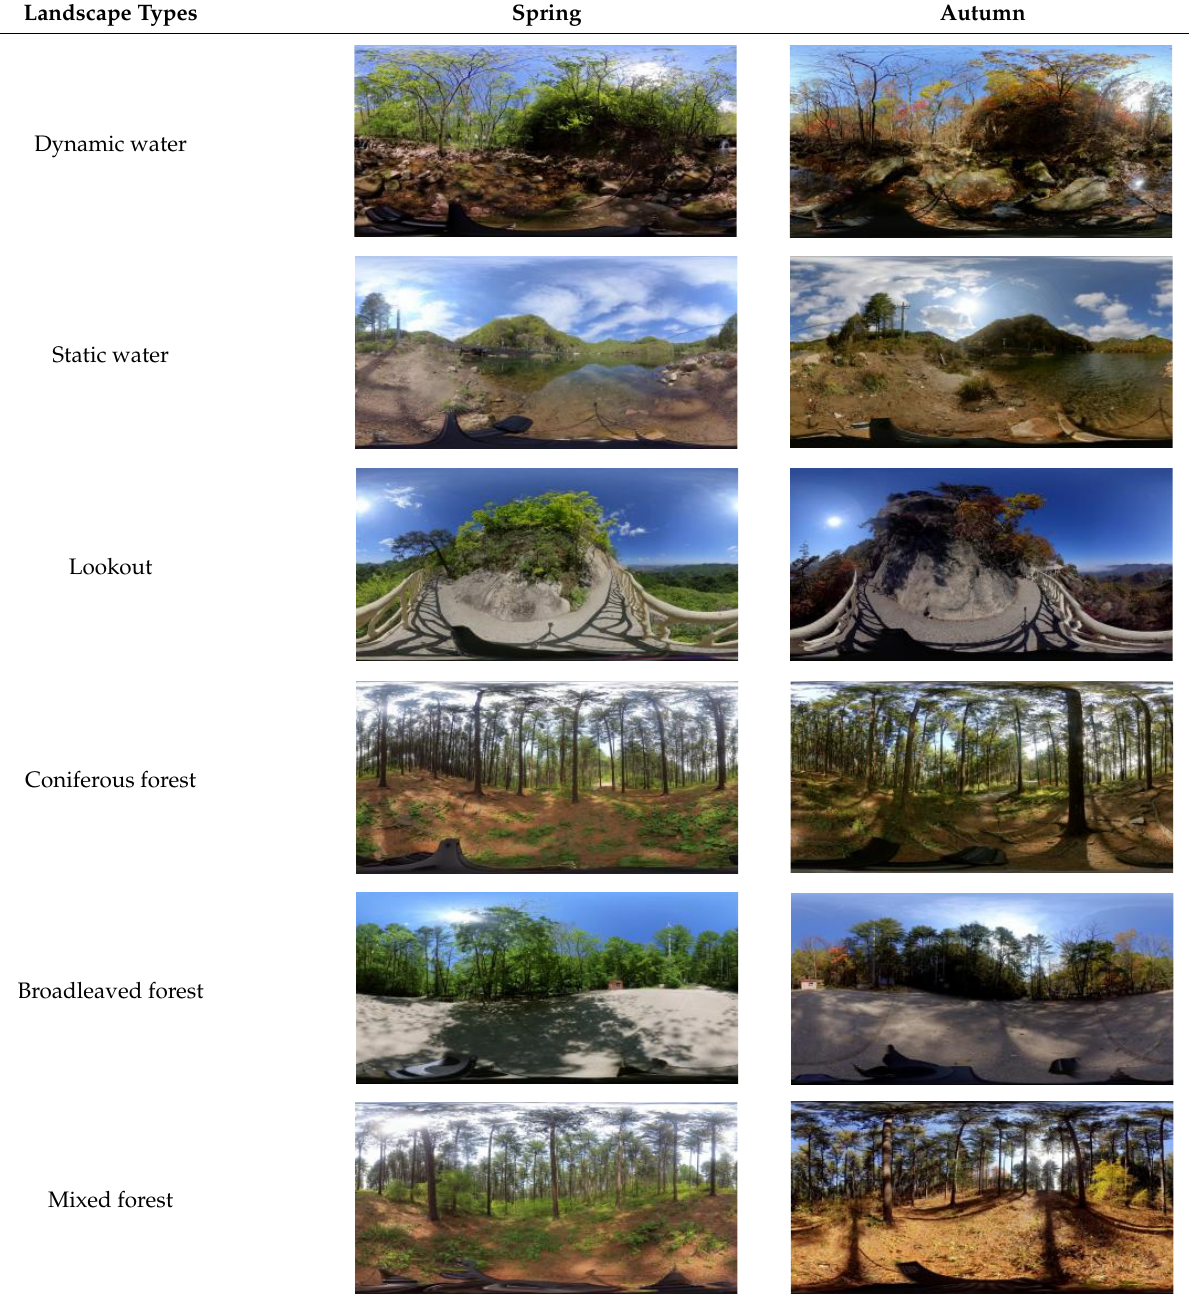
Table 1. Videos of six different types of forest landscapes.